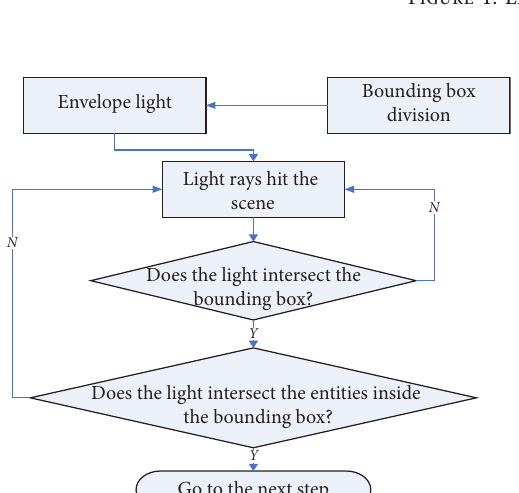
Figure 1: Light reverse tracking step.